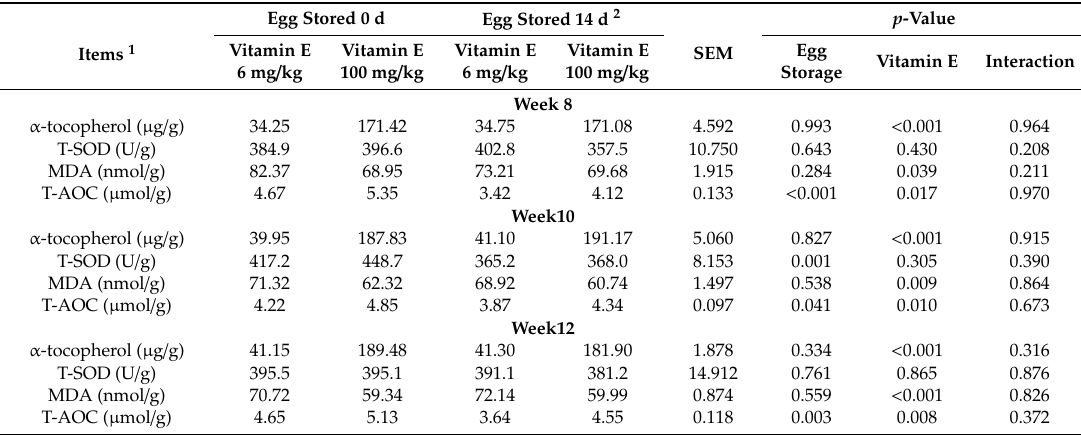
Table 4. The e ff ects of broiler breeder dietary vitamin E and egg storage time on the antioxidant status of egg